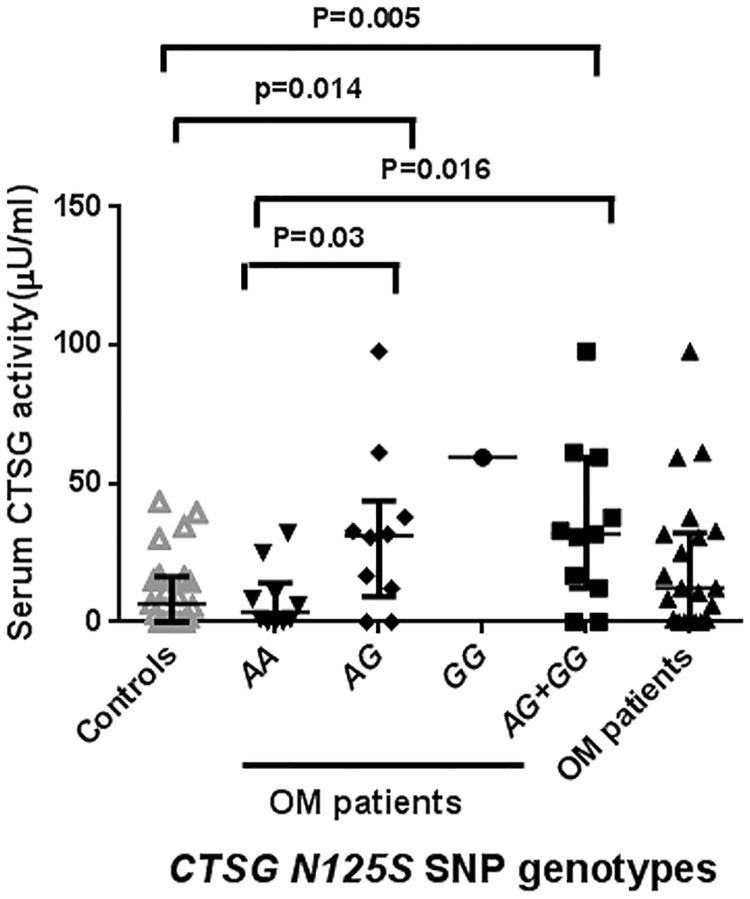
Serum cathepsin G (CTSG) activity in carriers of the different genotypes of the CTSG N125S (rs 45567233) polymorphism.Cathepsin G (CTSG) activity was determined in serum of osteomyelitis patients and controls by a colorimetric assay. Data are shown as the median and IQR of 21 patients with acute osteomyelitis, 10 carriers of the AA, 10 of the AG and 1 of the GG genotypes of the CTSG N125S (rs 45567233) polymorphism and 10 blood donors were assessed.